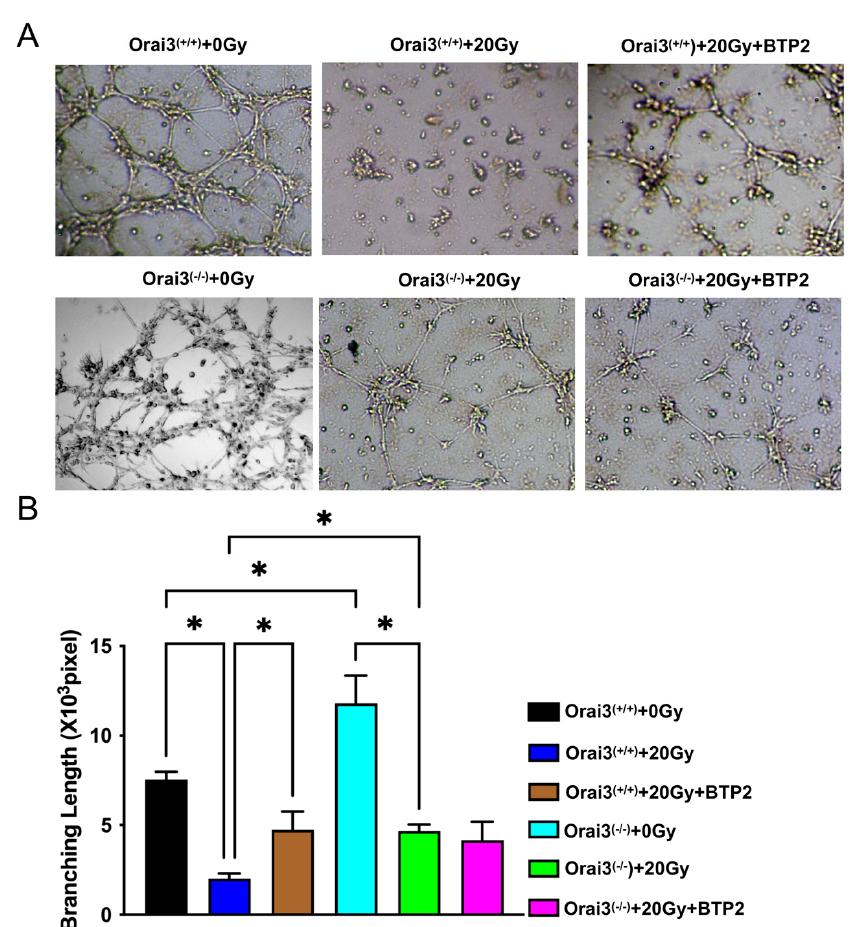
Figure 5. Role of Orai3 in X ‒ ray irradiation-induced inhibition of tube formation by rat brain microvascular endothelial cells (rBMECs). ( A , B ) Representative images of formed tubes ( A ) and summary data ( B ) of tube formation 24 h after rBMECs derived from wild ‒ type in Orai3 (+/+) were unexposed (0 Gy) or exposed (20 Gy) to X ‒ ray irradiation and untreated or treated with BTP2 (5 µM); and rBMECs derived from Orai3 knockout rats (Orai3 ( − / − ) ) were unexposed (0 Gy) or exposed to X ‒ ray irradiation (20 Gy) and untreated or treated with BTP2 (5 µM). Data are shown as the mean ± SEM ( n = 3), * p < 0.05 analyzed by one ‒ way analysis of variance followed by Dunne tt ’s multiple comparisons test.